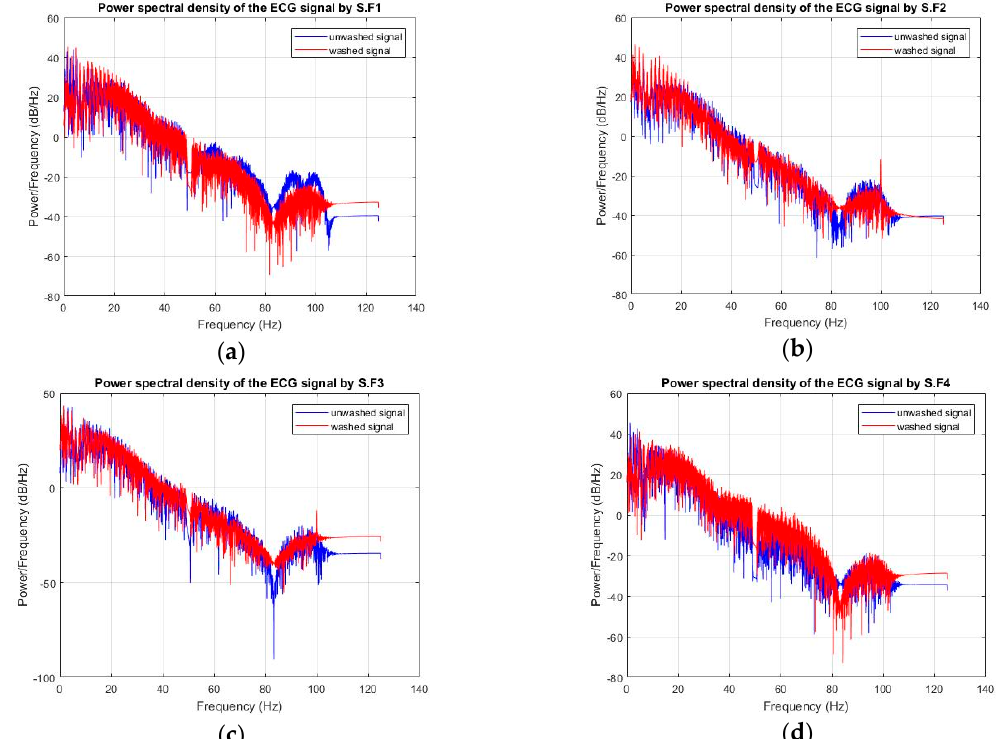
Figure 4. Surface resistance analysis (express wash). ( a ) Comparison of Ri/Ro ( b ) Comparison of actual resistance.